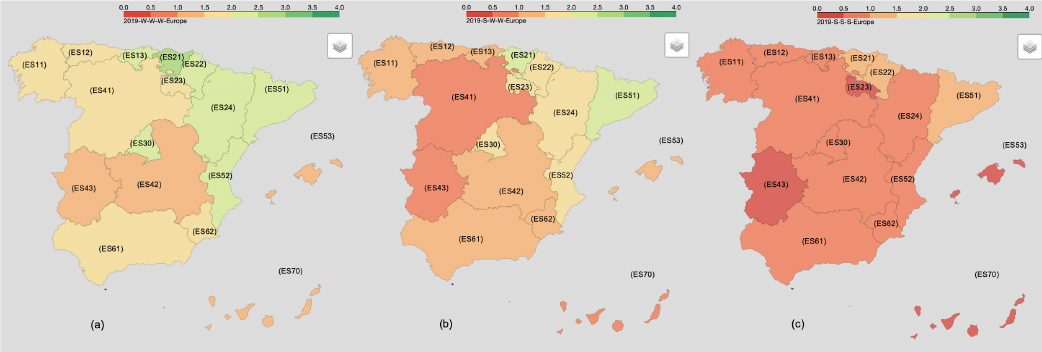
Figure 6. 2019 Innovation Performance of Spanish regions for different compensation degrees with respect to EU Reference Levels. ( a ) W-W-W Composite Indicator. ( b ) S-W-W Composite Indicator . ( c ) S-S-S Composite Indicator. Each performance interval has been subdivided into two subintervals